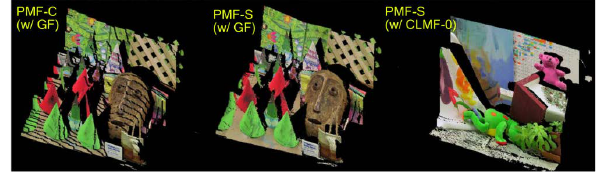
Fig. 5 Results from PatchMatch filter [26]. The algorithm accepts a stereo image pair as input, and estimates stereo disparity maps. The resulting images show a rendering from a new 3D viewpoint. Reproduced with permission from Ref. [26], c (cid:13) IEEE